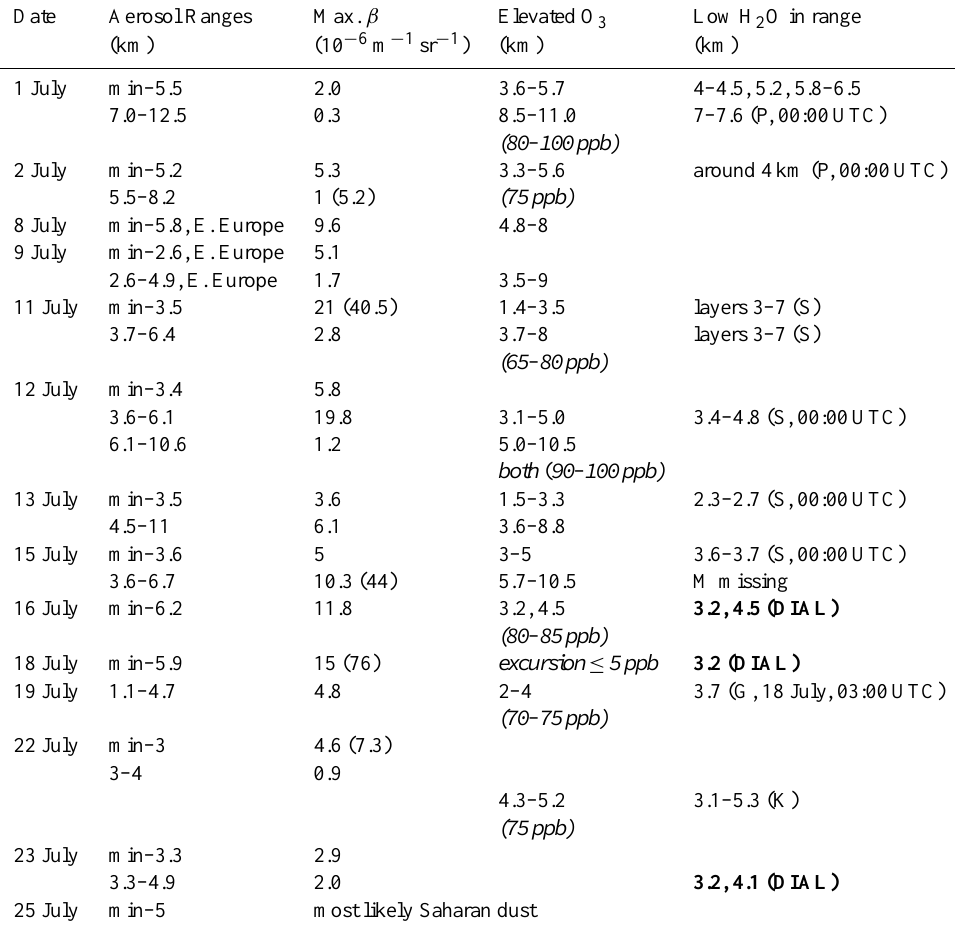
Table 1. List of the lidar sounding days at IMK-IFU and UFS (Garmisch-Partenkirchen, Germany) during the smoke period in July 2013; min means the minimum altitude of observation (1000–1200ma.s.l.), P, S, M, K, G the radiosonde stations Payerne, Stuttgart, Munich, Kümmersbruck, and Graz, respectively. The sonde stations were selected based on the trajectory results. Maximum backscatter coefficients in brackets could be due to clouds. Sonde RH is listed only if significantly below 10%. Typical peak ozone values are printed in italics, layer positions for DIAL measurements in